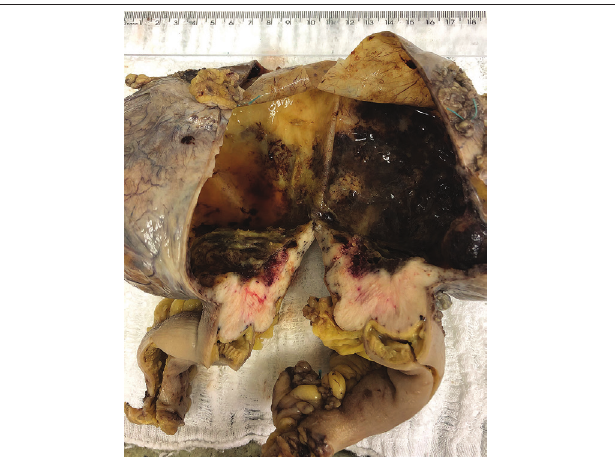
Figura 1 − Macroscopia: lesão cística com área sólida brancacenta e paredes hemorrágicas junto ao